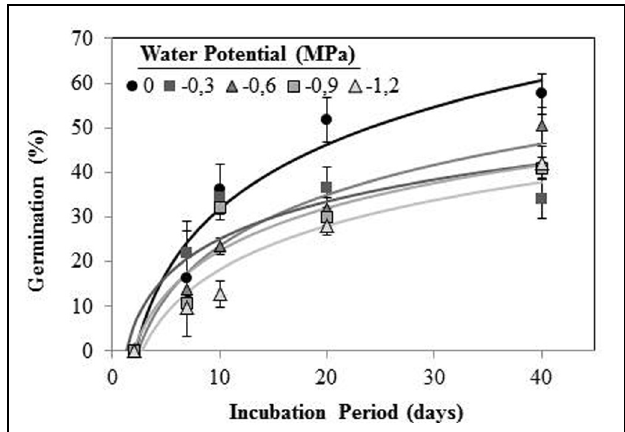
FIGURE 3 | Cumulative germination percentage of O. crenata conditioned at 20 ◦ C under different water potentials (MPa) during 40 days. The lines were fitted according to logarithmic equation [G (%) = a + log ( days )] for each water potential. Points represent the average of 12 repetitions. Bars represent the SD of the mean.